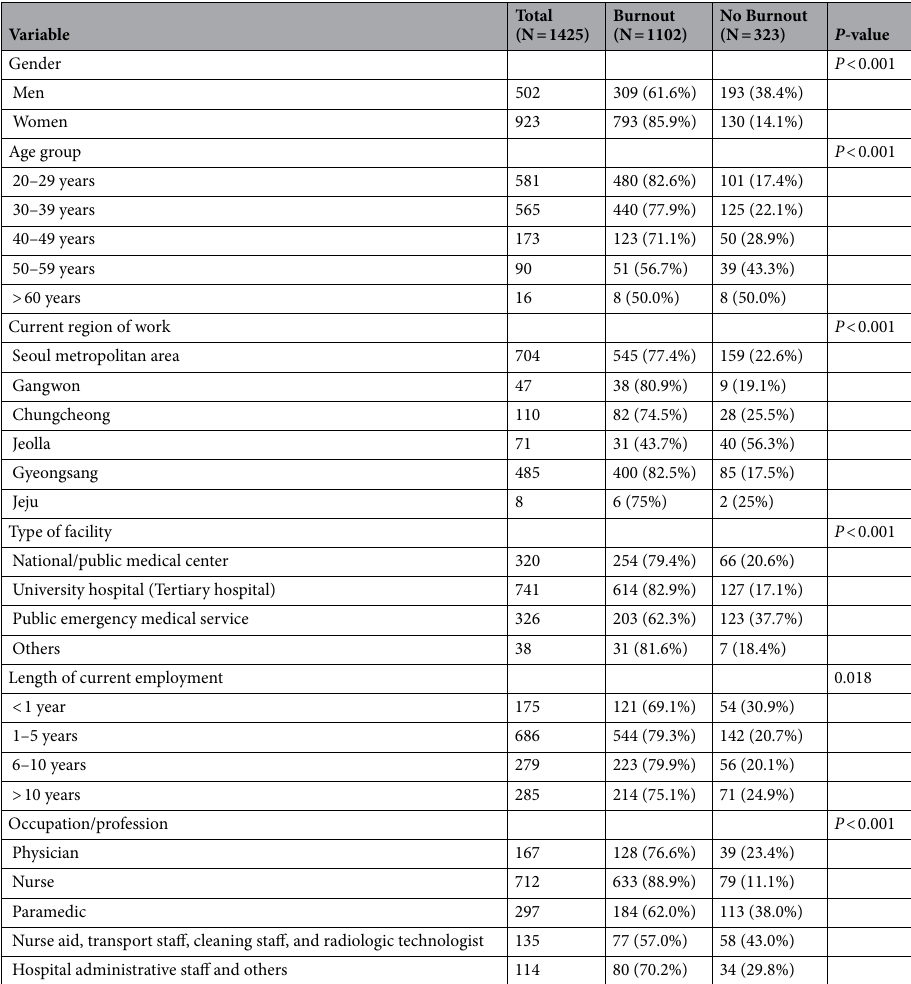
Table 2. Characteristics of the study population and burnout rate according to the